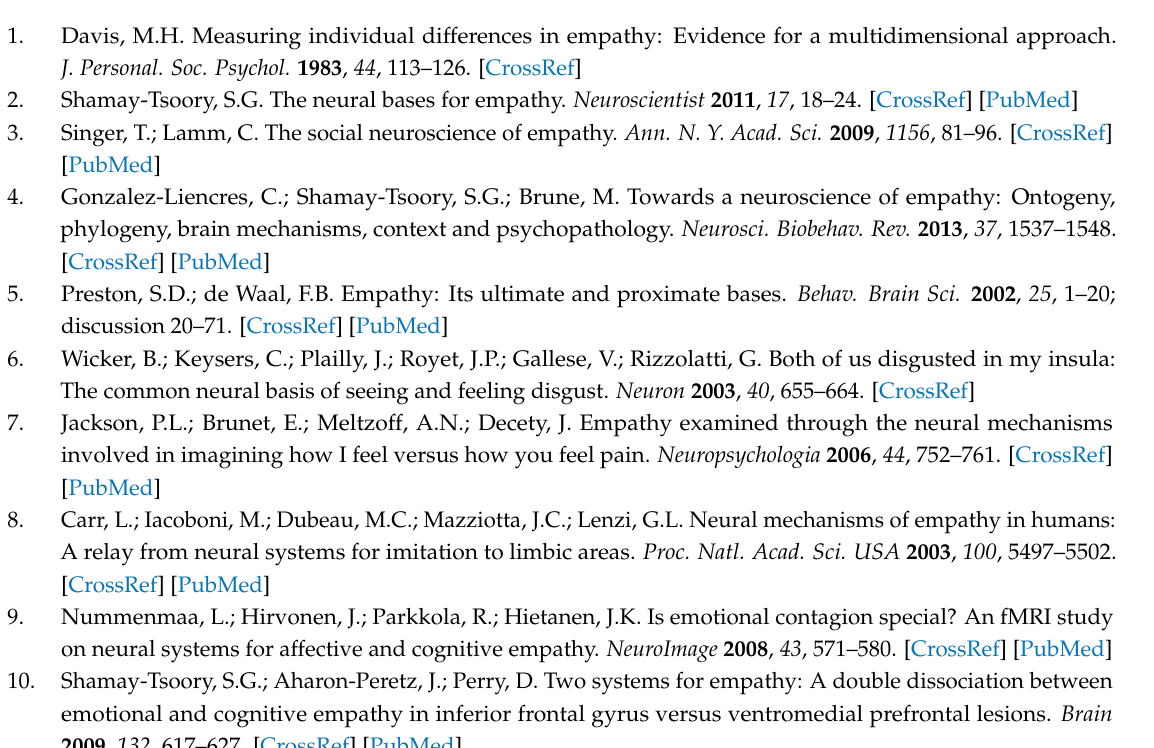
Table S1: Psychometric characteristics of the emotional empathy measure used in the current sample and comparative psychometric data from a second, independent sample; Table S2: Conjoint factor analysis of emotional empathy items used in the current study with established trait indicators of emotional and cognitive